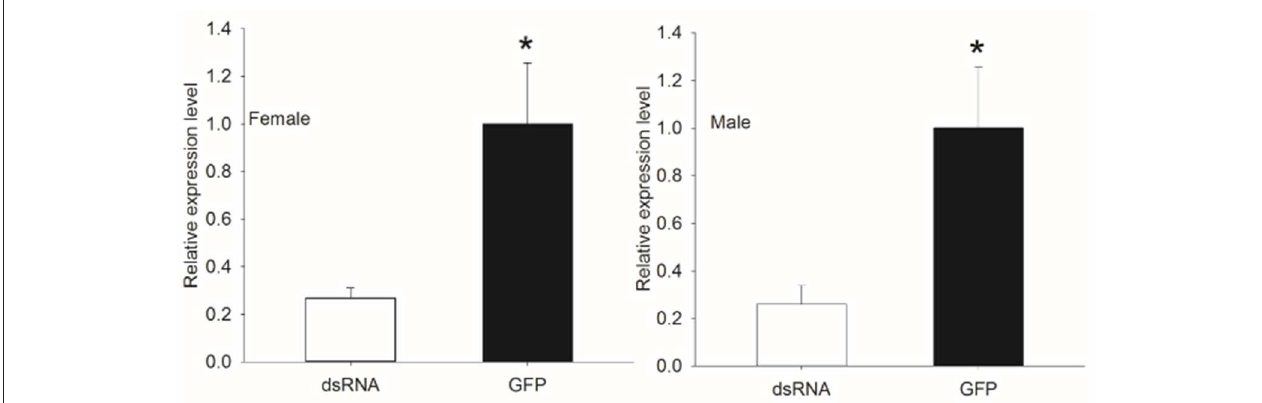
FIGURE 5 | Decrease in Bdorobp2 gene expression after dsRNA injection. The dsRNA of Bdorobp2 was injected into the male and female abdomens. The change in the transcript level was examined by qPCR with three replicates. The expression of Bdorobp2 decreased significantly in the dsRNA-injected heads of adults (shown by the black rectangle), compared with the gene expression in the heads injected with green fluorescent protein (GFP) solution (shown by the blank rectangle). Vertical bars indicate the SD of the means ( n = 6), and the asterisks (*) indicate the significant difference at the level of p < 0.05 based on the Student’s t -test.